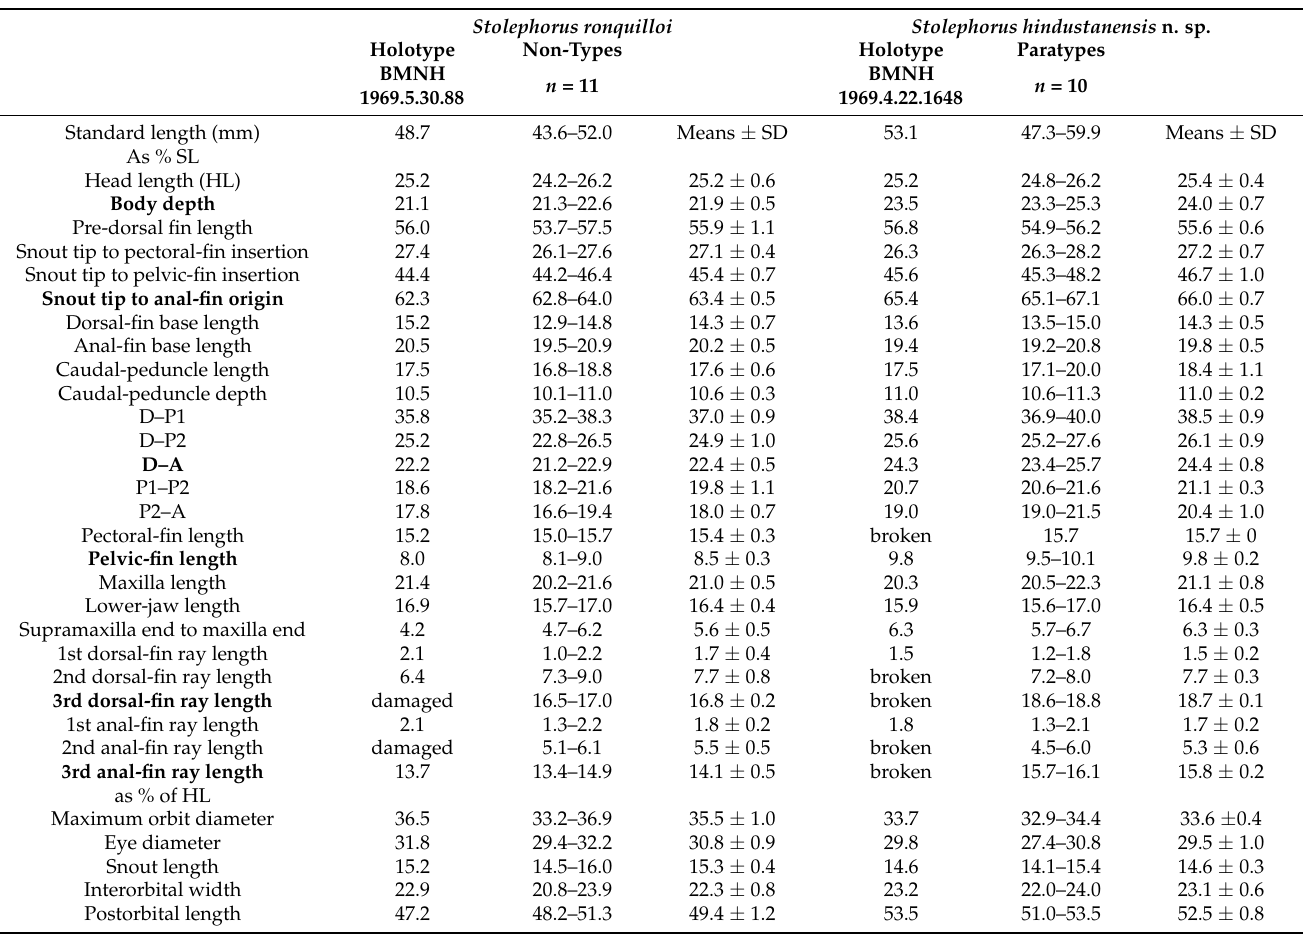
Table 2. Morphometrics of specimens of Stolephorus ronquilloi and Stolephorus hindustanensis n. sp. Bold characters indicate non-overlapping morphometrics between the two